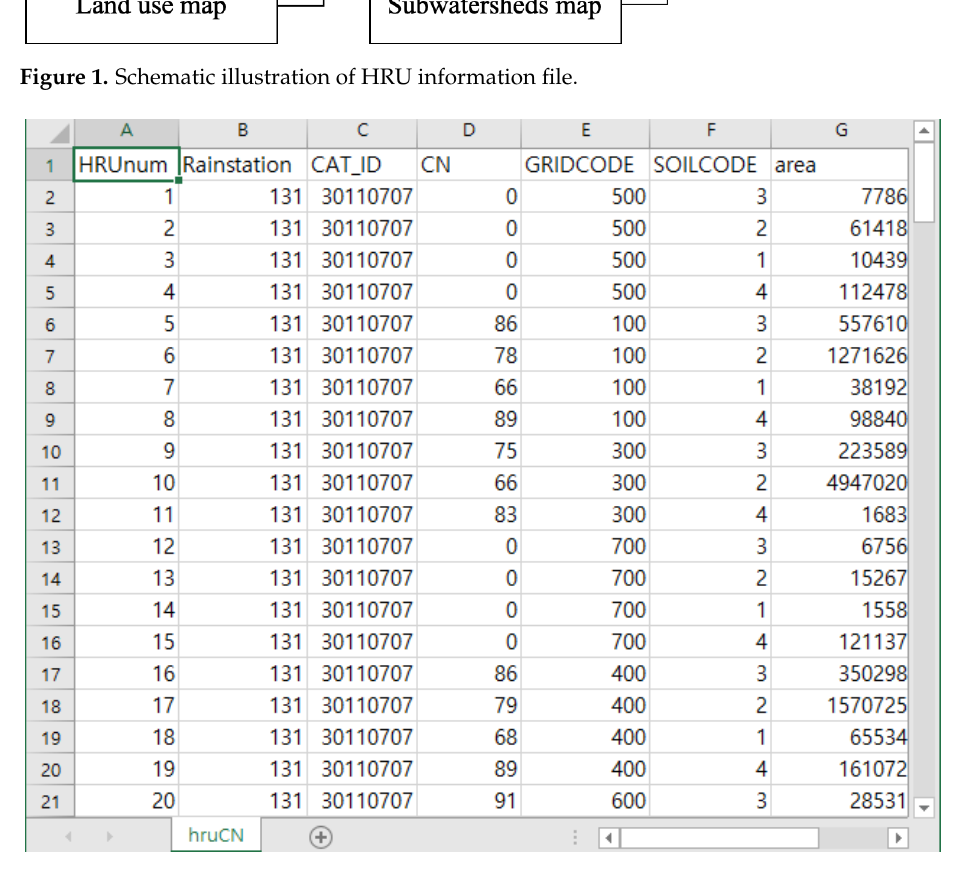
Figure 2. Example of HRU information file.